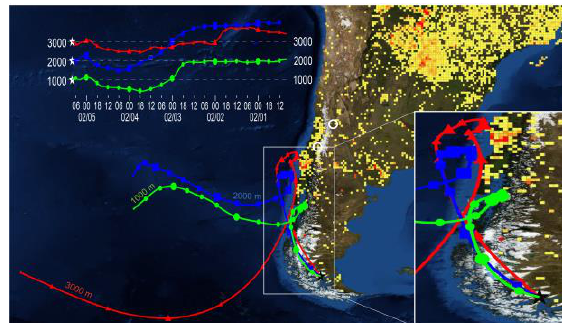
Figure 2. 5-day HYSPLIT backward trajectories arriving over Punta Arenas at 2 km (red line) and 3 km (blue line) on 05 February 2019, at 08:00 UTC. The underlying fire map derived from FIRMS shows all fires (yellow and red spots) detected during January 2019 and the locations of the two active volcanoes (white circles).